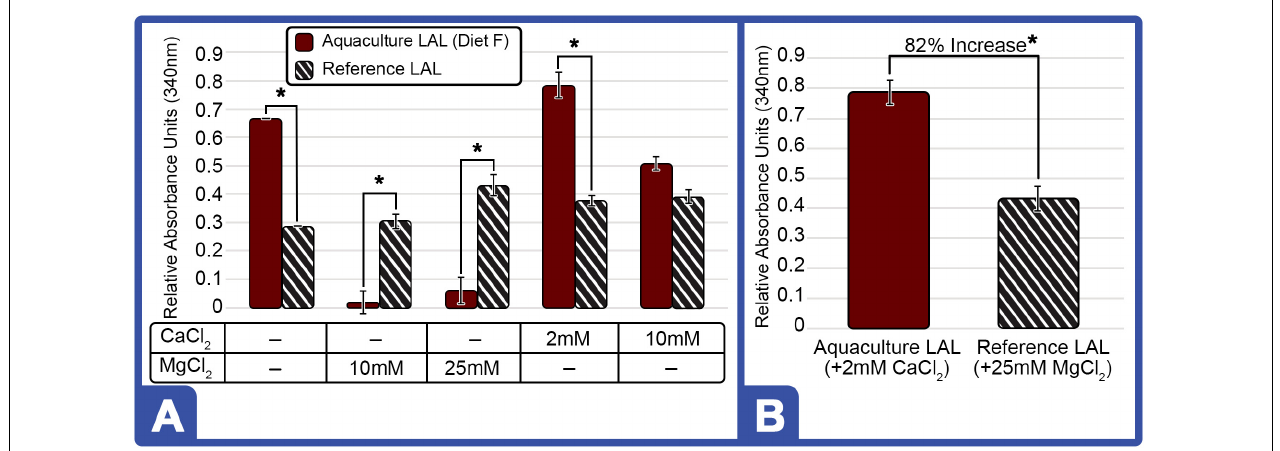
FIGURE 9 | Effect of Different Cations on LAL-LPS Reactivity of Aquaculture and Reference LAL. (A) Effect of MgCl 2 and CaCl 2 addition on LAL (300 µ g) from HSCs fed Diet F in Feed Study 3 vs. reference LAL at 5.0 EU/mL of LPS. LAL reactivity to endotoxins evaluated for aquaculture (Solid Bars) and reference (Striped Bars) at 340 nm on microplate reader after 1-h incubation at 37 ◦ C (B) Maximum LAL reactivity of aquaculture LAL (Diet F; Feed Study 3) vs. reference LAL at 2 mM CaCl 2 and 25 mM MgCl 2 , respectively. Results are represented as mean ± SD between individual LAL assays performed in triplicate. * p < 0.05 of aquaculture LAL compared to the reference LAL for the respective cation conditions evaluated.